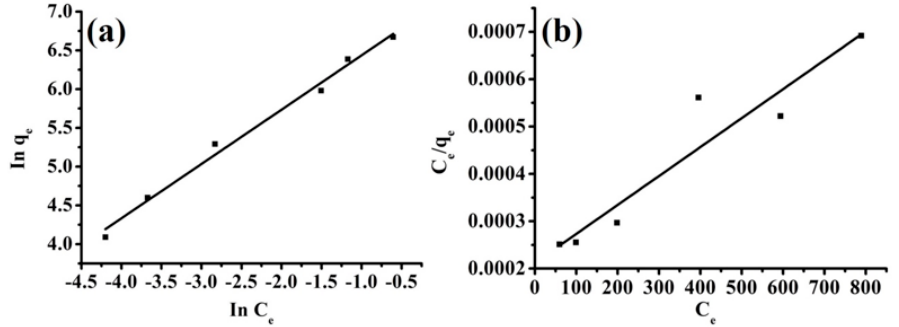
Figure 11. Plots of ( a ) Frendlich isotherm and ( b ) Langmuir isotherm models for Al 3+